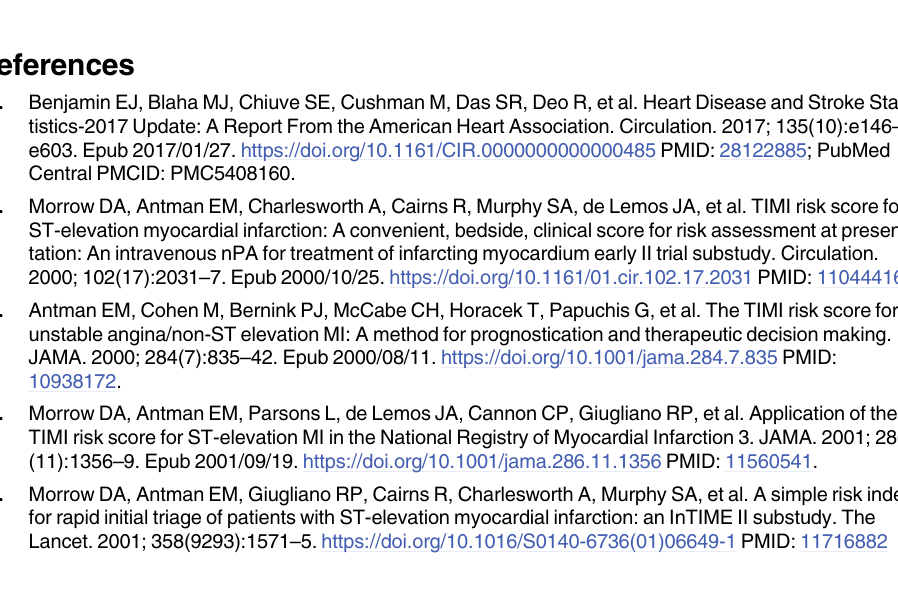
cation programming interface (API) that returns the prediction results was tested to show the correct behavior for a subset of records in the dataset. S3 Fig. Model performance illustrated by precision-recall curve for test subset in KOTOMI, GRACE score, and TIMI risk index. AUPRC indicates area under precision-recall curve. S4 Fig. Model calibration. Calibration plots were depicted for original model (left panel) and model calibrated by Isotonic Regression (right panel) using training data (A) and test data (B). Samples were divided into ten